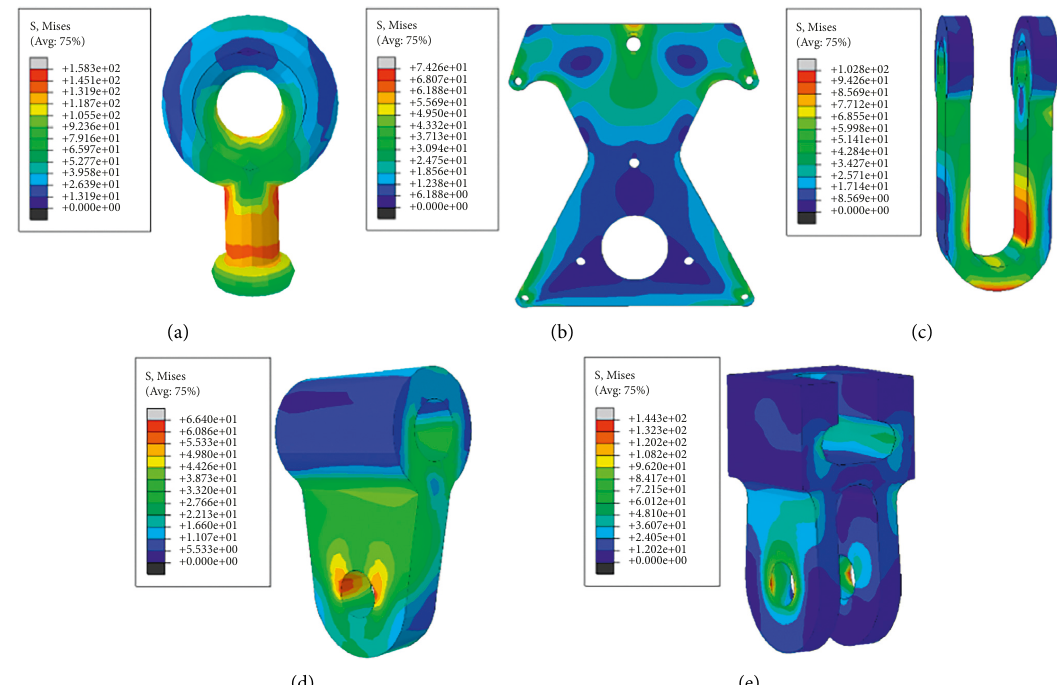
Figure 46: Stress cloud picture of some fittings in suspension string.